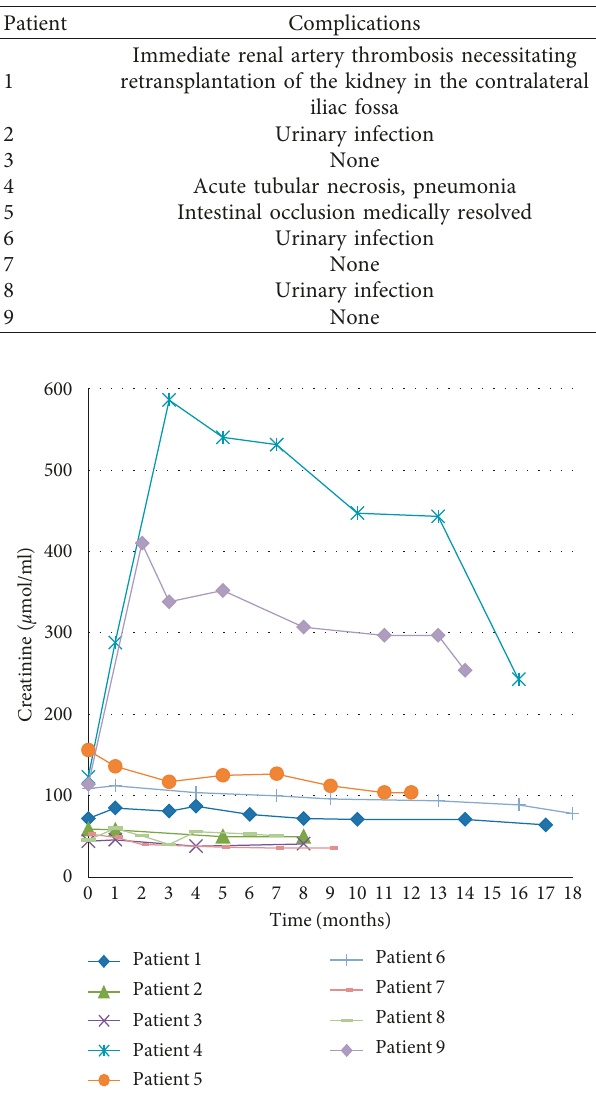
Figure 1: Early outcome: renal function.